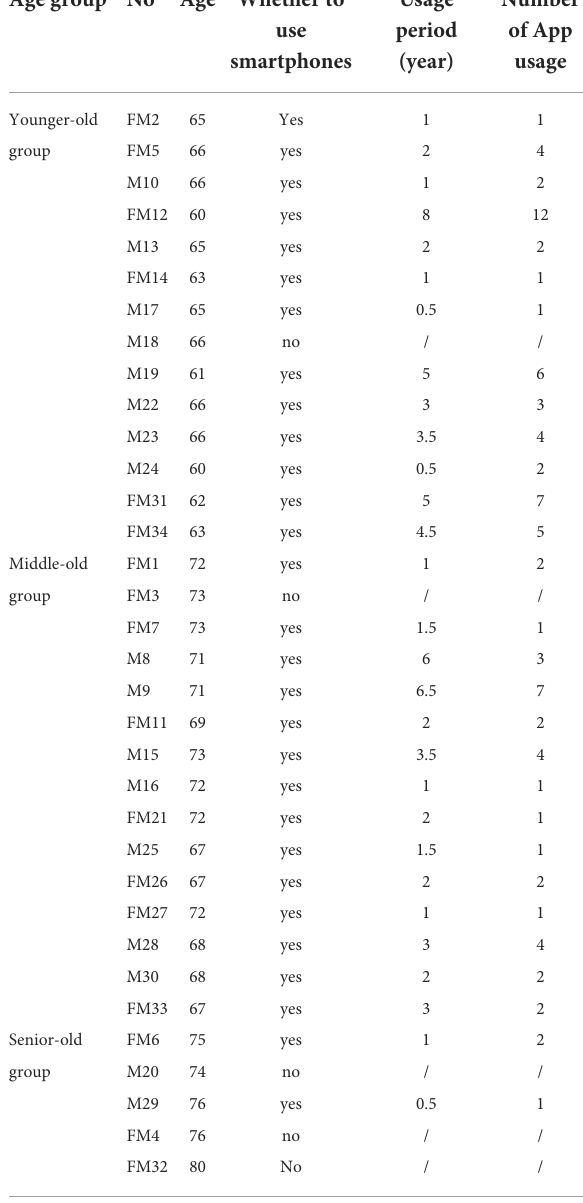
TABLE 1 Basic information of participants.